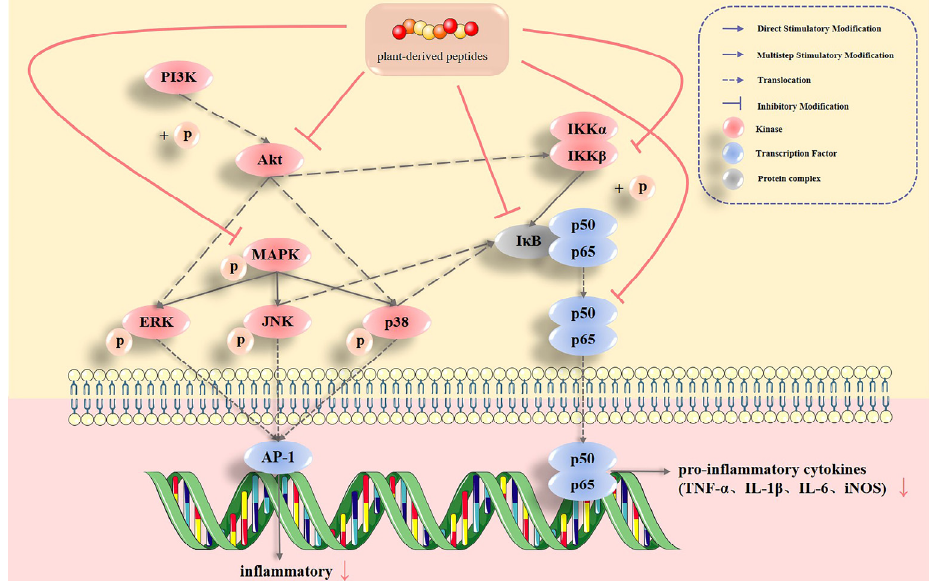
Figure 1. Regulation of inflammatory signaling pathways by plant-derived bioactive peptides. (PI3K: phosphatidylinositol 3-kinase; Akt: protein kinase B; MAPK: mitogen-activated protein kinase; ERK: extracellular regulated protein kinases; JNK: c-Jun N-terminal kinase; p38: p38 MAPK; AP-1: activator protein 1; IKK: inhibitor of kappa B kinase; I κ B: inhibitor of NF- κ B; p: phosphorylation; TNF- α : tumor necrosis factor- α ; IL-1 β : interleukin-1 β ; IL-6: interleukin-6; iNOS: inducible nitric oxide synthase).